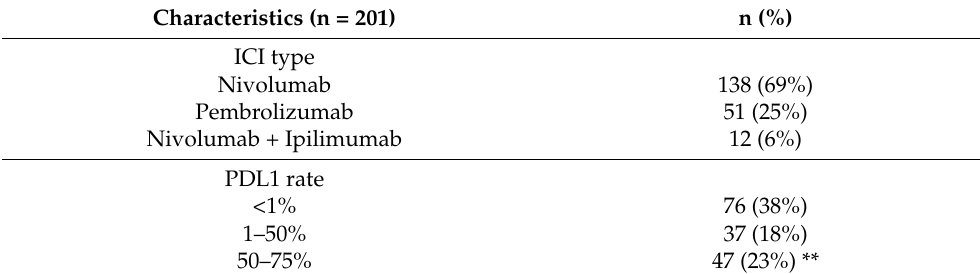
Table 1. Cont. Characteristics (n =